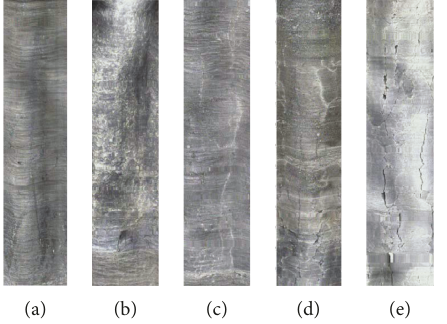
Figure 15: The observations of the blasting effect. (a) scheme 1; (b) scheme 2; (c) scheme 3; (d) scheme 4; (e) scheme 5.